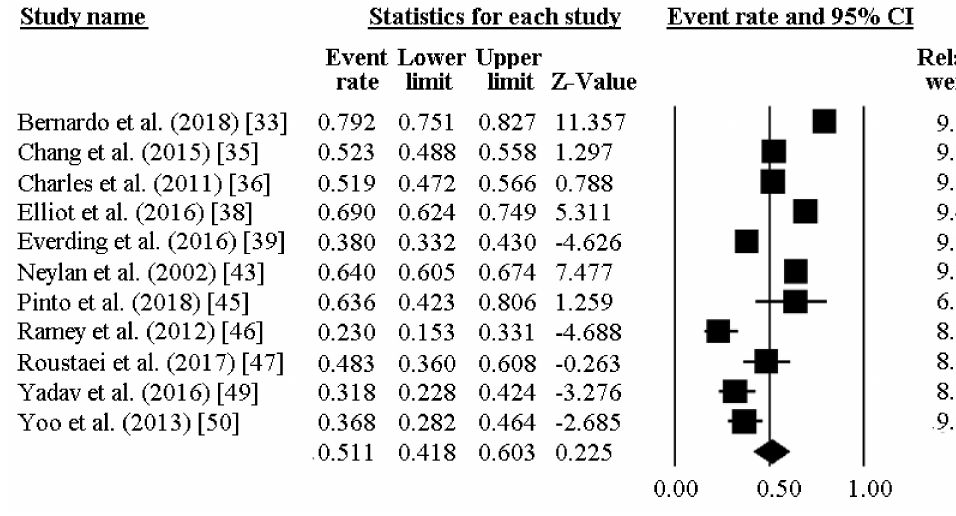
Figure 2. Prevalence of low sleep quality in police officers.